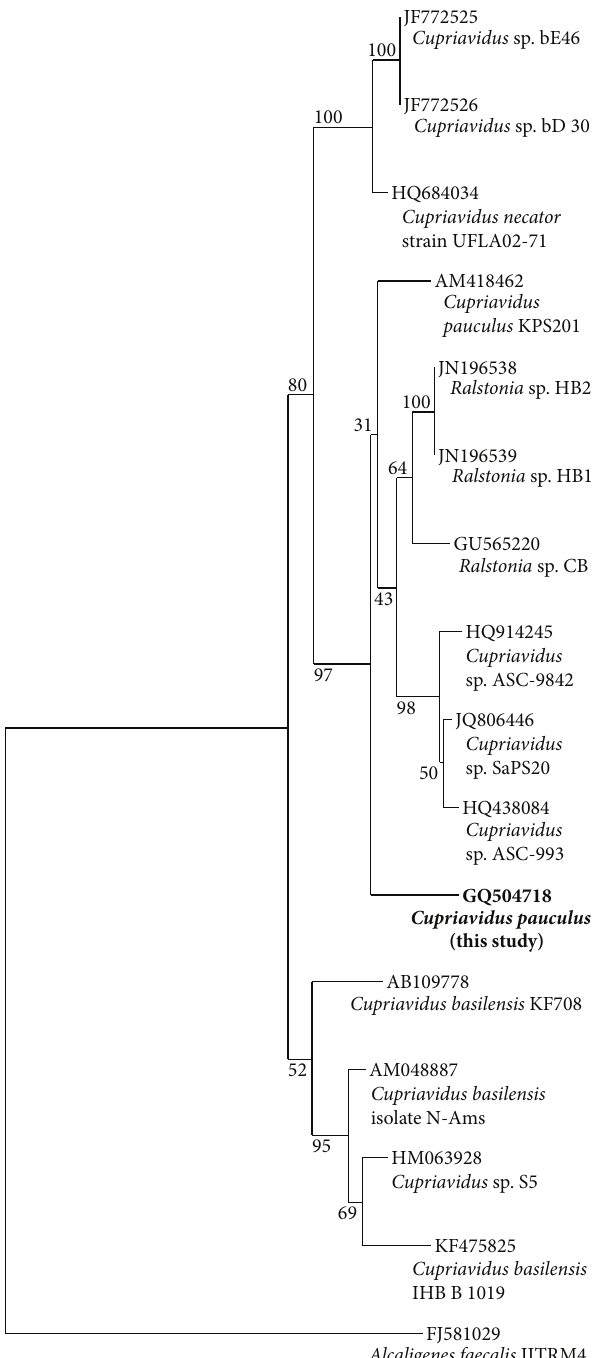
Figure 1: Phylogenetic analysis of the bacterium of this study based on 16S rRNA gene homologies. (The species/strain designations used for comparison are included in the figure. Alcaligenes faecalis IITRM4 served as the